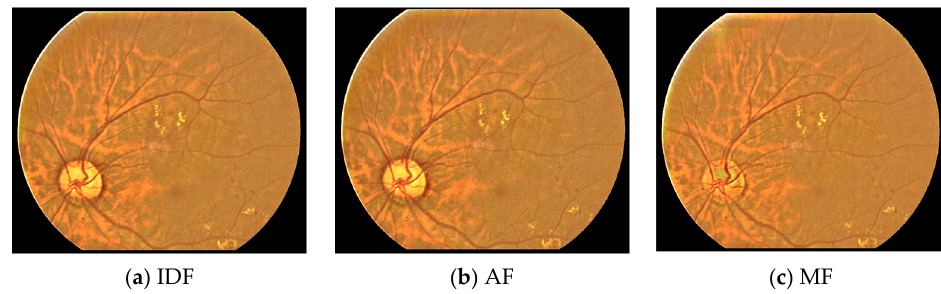
Figure 5. The corrected color images of sample in Figure 1 generated using the three filters.